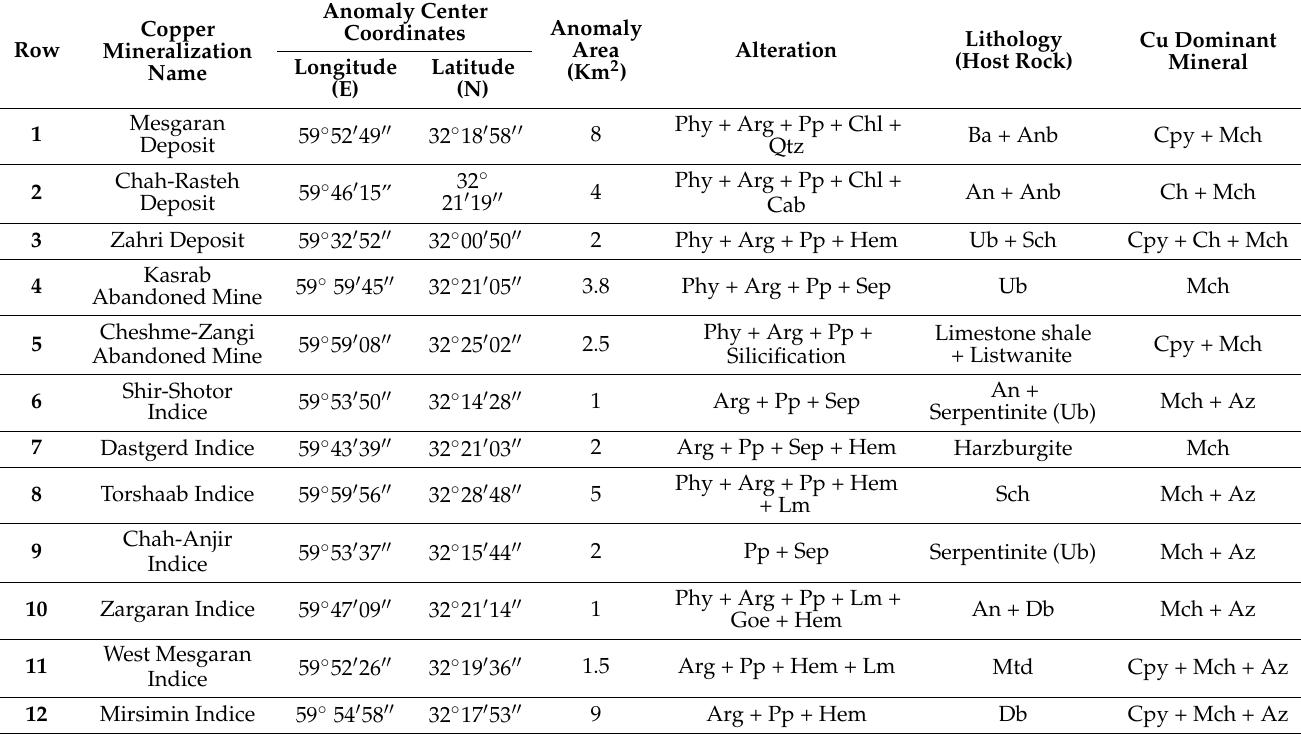
Table 1. Classified information of 14 copper mineralization points in Sahlabad